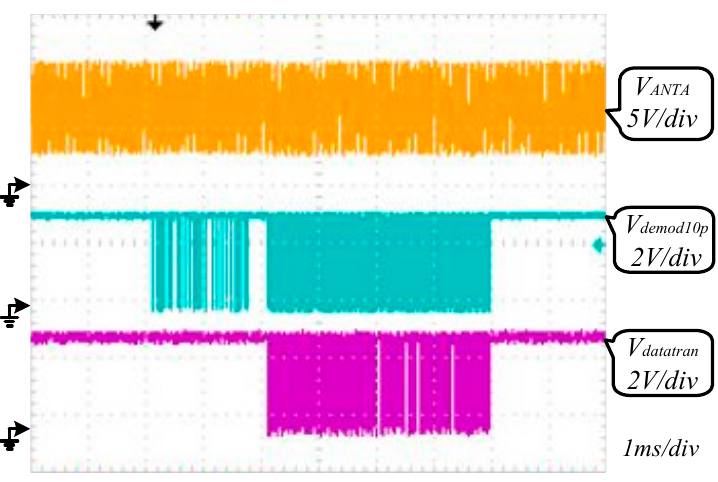
Figure 13. Measured waveform of the communication between reader and tag.